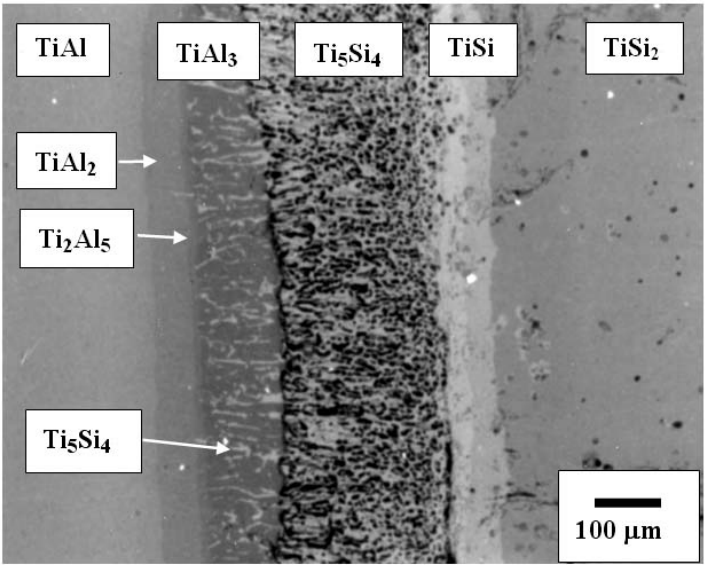
Figure 10. Back Scattered Electron (BSE) image showing TiAl/TiSi annealed at 1,373 K for 200 h